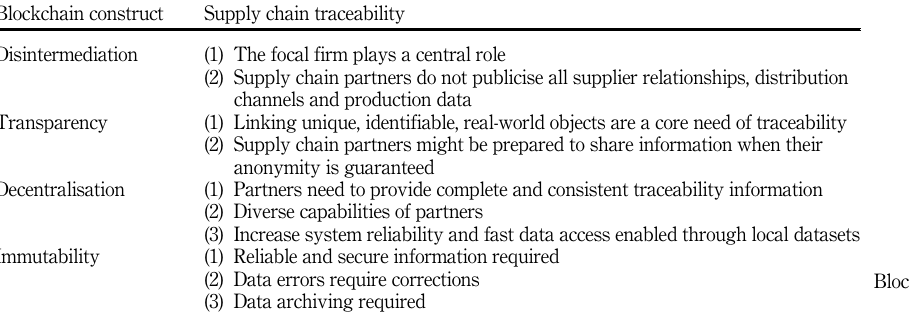
Table 4. Blockchain